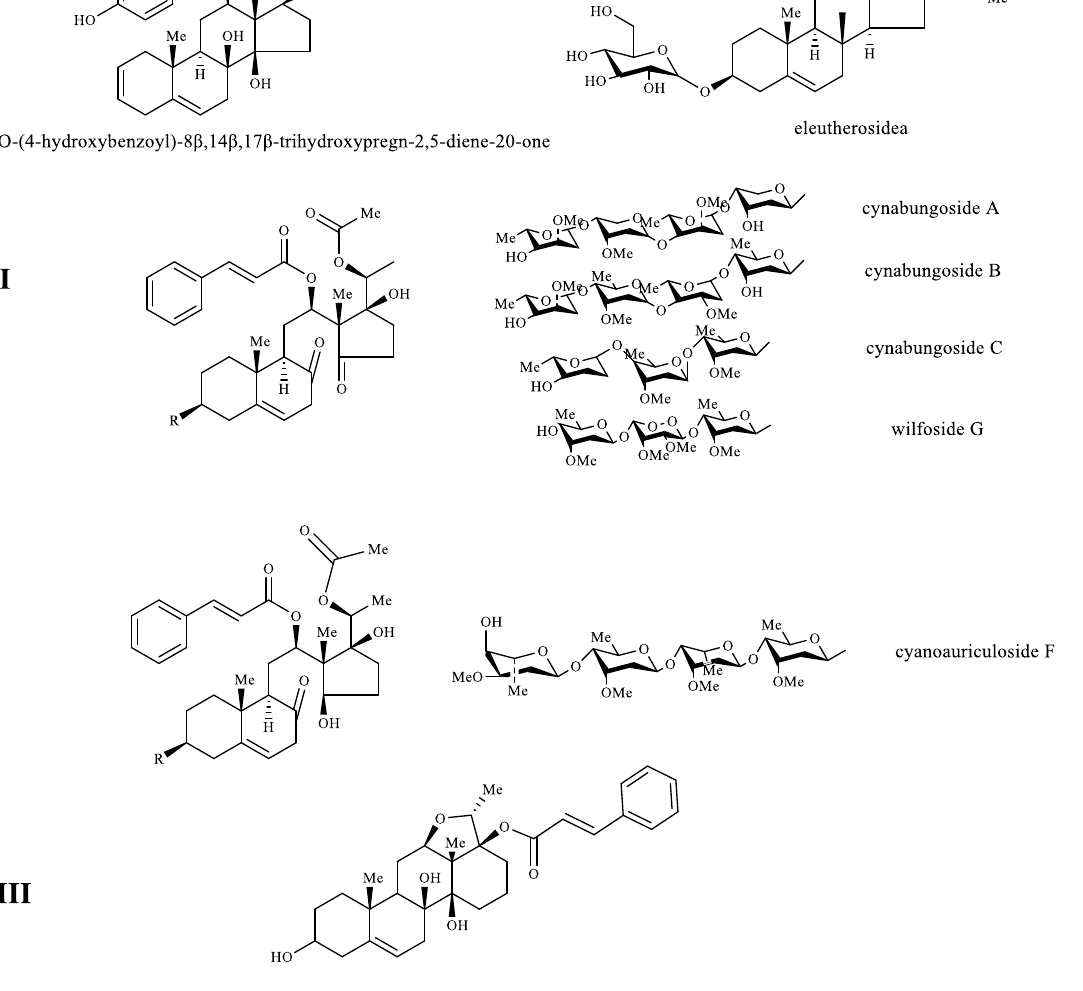
Figure 3. Representative structures of C 21 -steroid compounds isolated from CA , CB and CW . Pregnane ( I ), seco-pregnane ( II ), trihydroxypregnane ( III